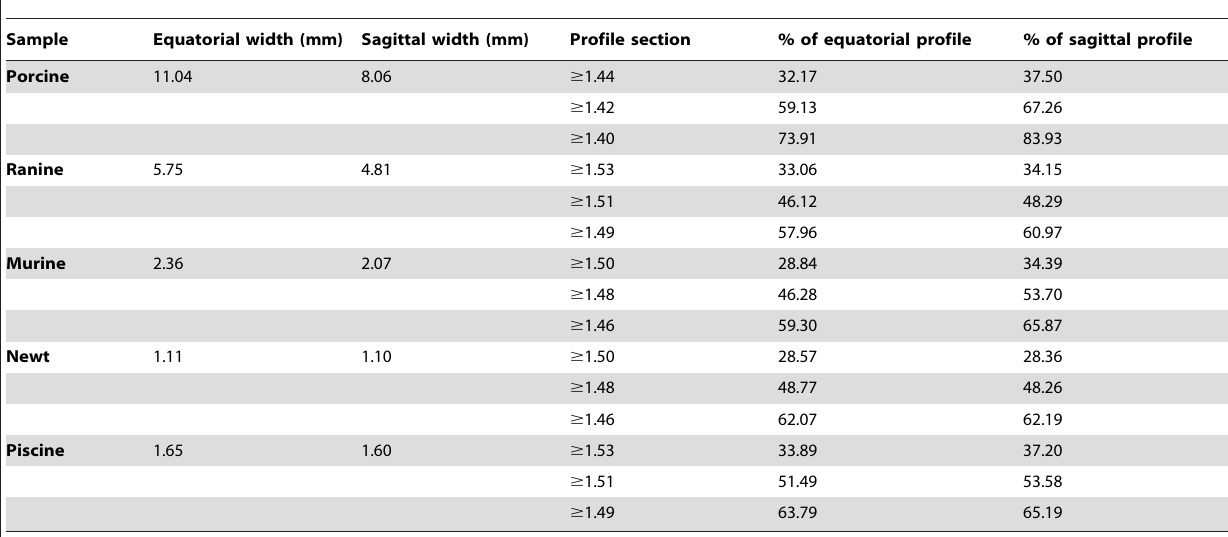
Table 2. Widths of equatorial and sagittal refractive index profiles and the proportions of each profile with refractive index equal to and above a given value in lenses from five